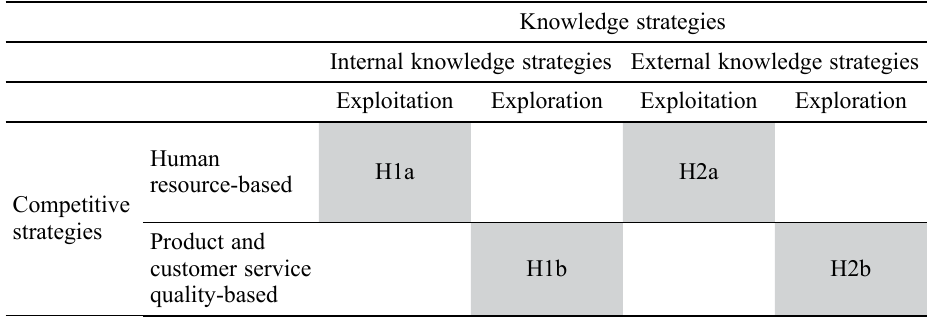
Table 1. Theoretical framework: knowledge strategy and competitive strategy alignment in